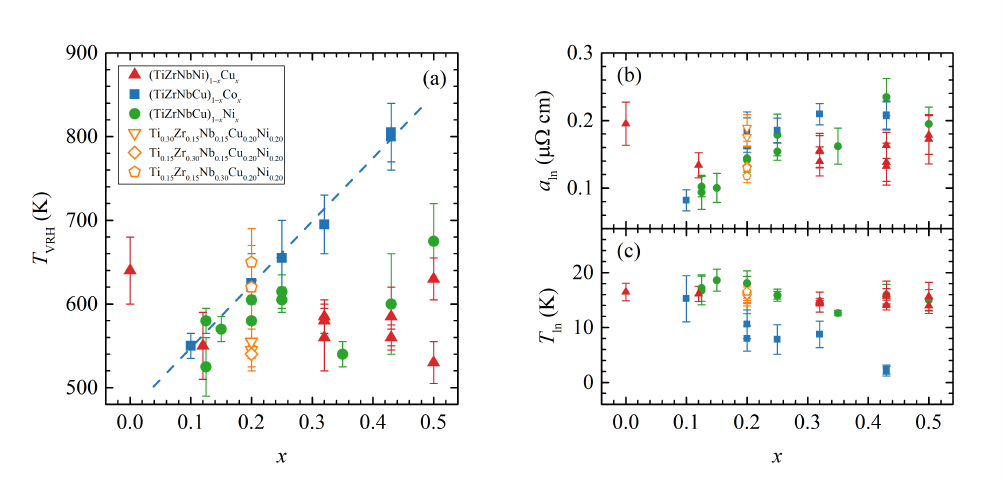
Figure 4. ( a – c ) The composition x dependence of the fitting parameters T VRH , a ln and T ln , respec- tively, for ( TiZrNbNi ) 1 − x Cu x (red triangles), ( TiZrNbCu ) 1 − x Co x (blue squares), ( TiZrNbCu ) 1 − x Ni x (green circles) and three additional alloys with fixed (CuNi) content (open triangles, diamonds and pentagons). The dashed line is a guide to the eye. Multiple points for the same x correspond to multiple measured